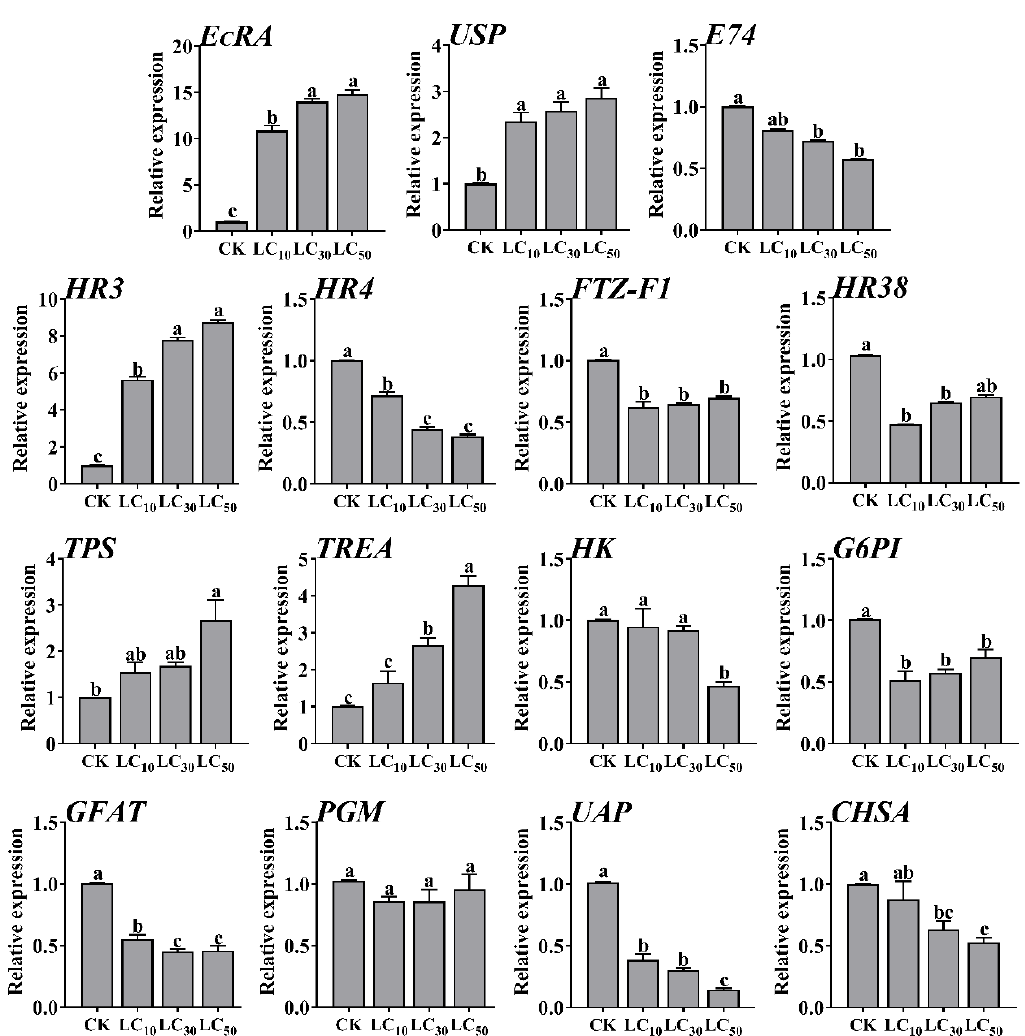
Figure 3. Relative expression levels of ecdysone signaling pathway genes in S. exigua under MET treatment. Relative expression levels of ecdysone signaling pathway in L3 larvae were examined 72 h after exposure to the control treatment DEPC water (CK) or MET at three different dosages (LC 10 , LC 30 , and LC 50 ). The bars represent the average (± SE) of biological repeats. Different letters above the bars indicate significant differences ( p < 0.05), based on one-way ANOVA and at least significant difference test.